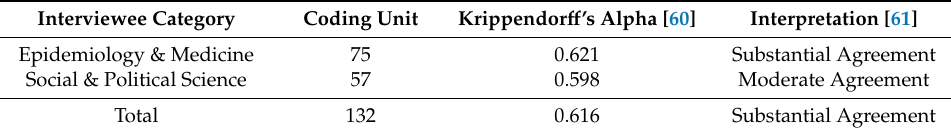
Table 3. Inter-coder agreement in pilot coding using two transcripts.